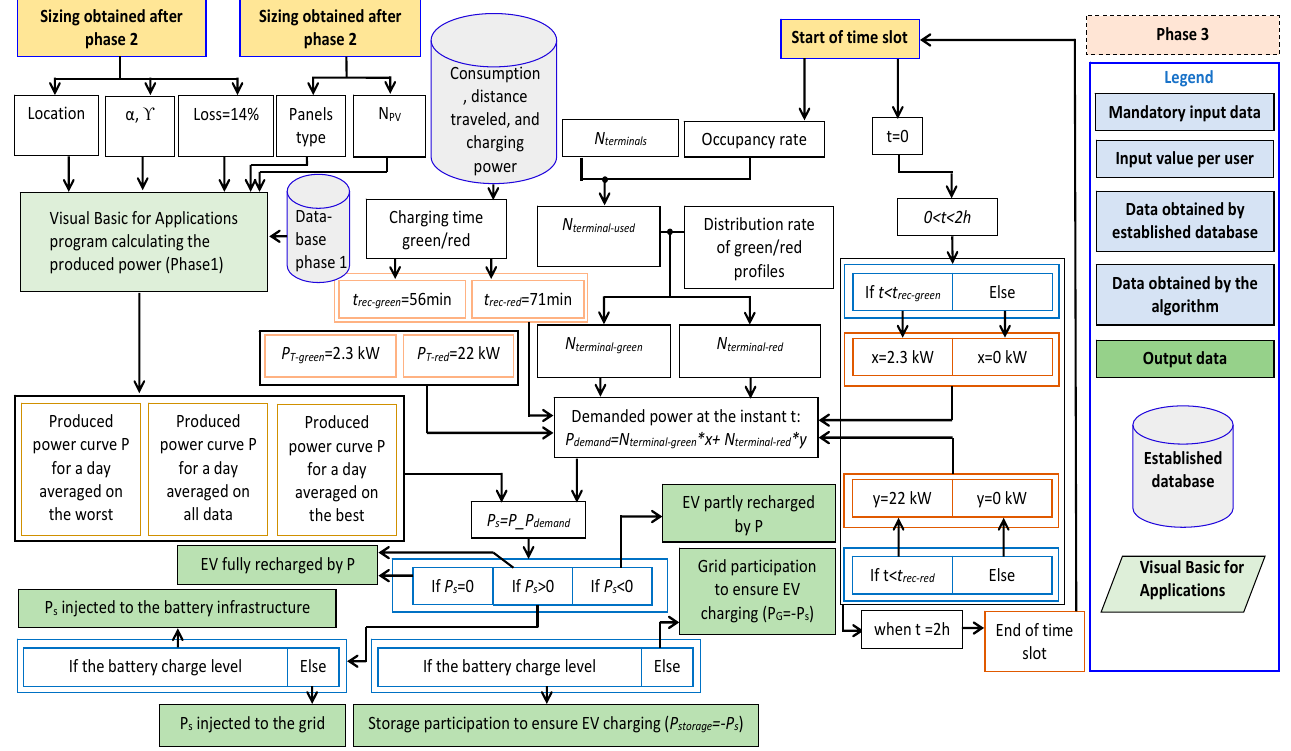
Figure 6. Flow chart of phase 3.